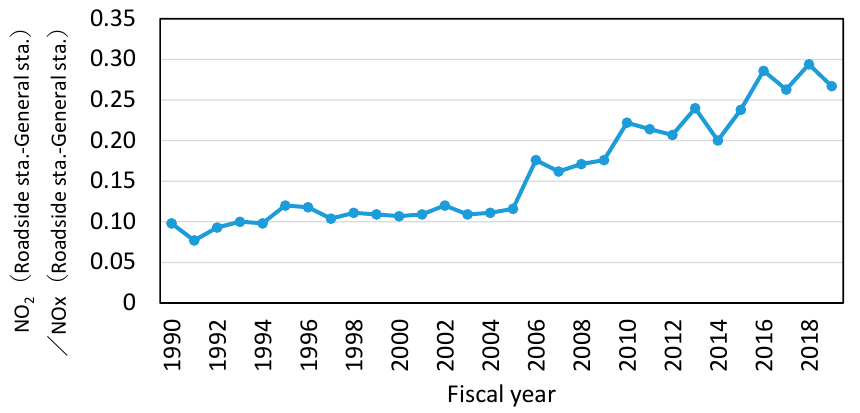
Figure 21. Trends in the average of NO 2 /NOx at Roadside sta. less that at General sta. at night during the cold season. NOx and NO 2 : same as Figure 19.